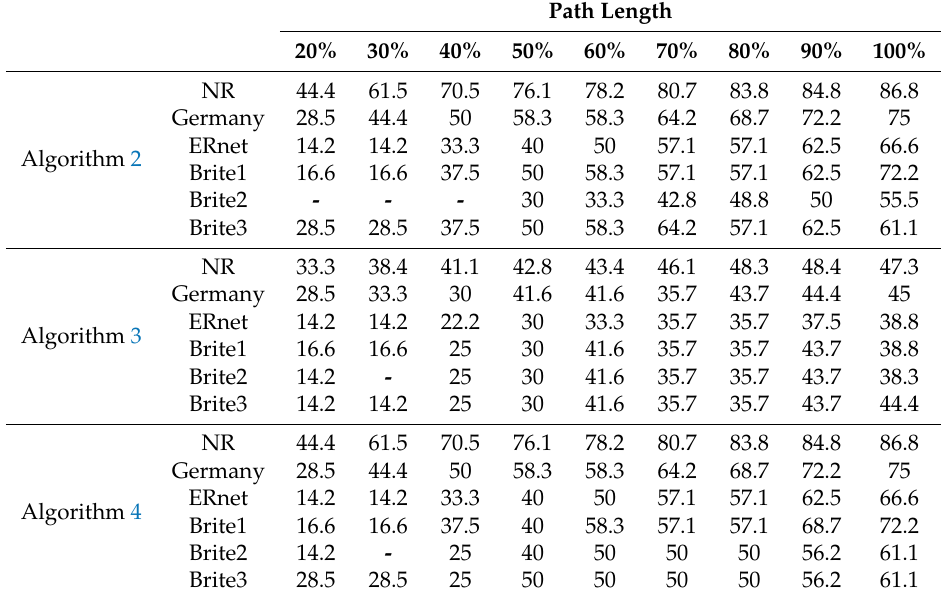
Table 4. Average cost reduction rate of Algorithms 1–3 are compared as a function of the normalized path